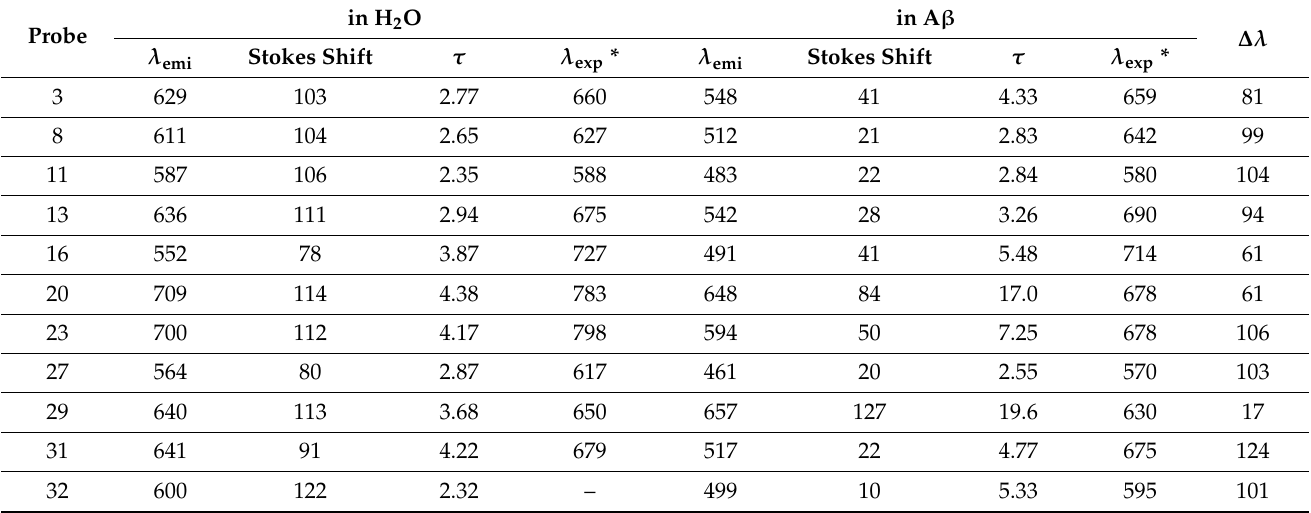
* Experimental fluorescent wavelength measured in aqueous solution and in A β . The emission peak calculated for probes 3, 8, 11, and 13 are 629, 611, 581, and 636